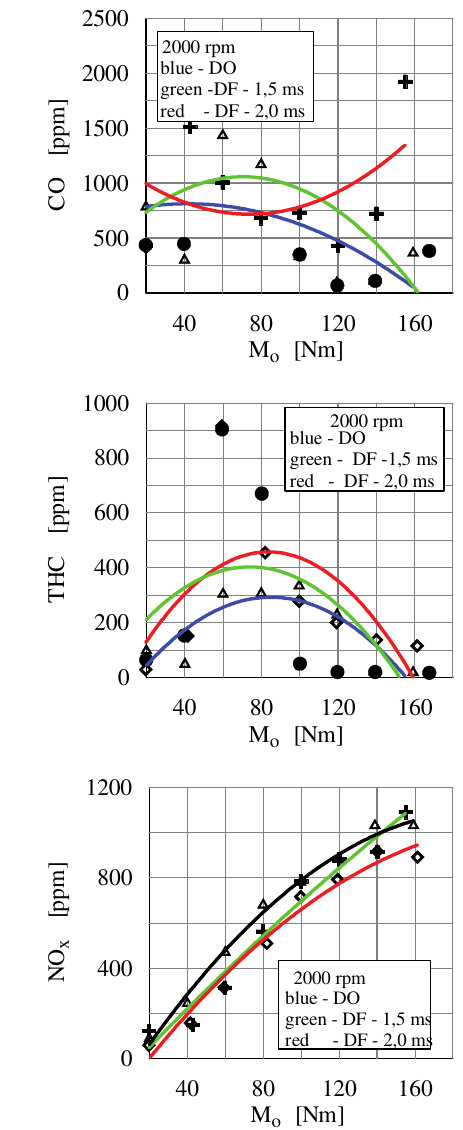
Fig. 7. Comparison the concentration of toxic component in exhaust Fiat 1.3 MJT engine fuelled with diesel oil and dual fuel for varies times of gas injectors opening: engine speed 2000 rpm, times of gas injectors opening 1.5 ms, 2.0